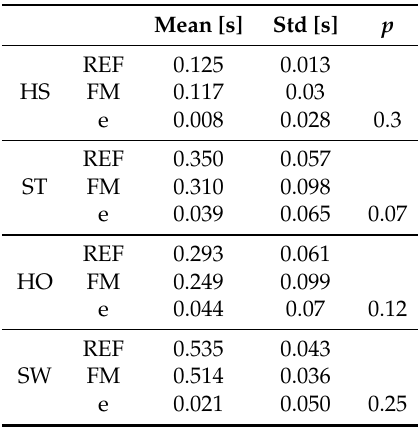
Table 2. Mean and standard deviation of the duration of the gait phases (REF and FM), mean and standard deviation of errors ( e ij ) and p -values of the statistical